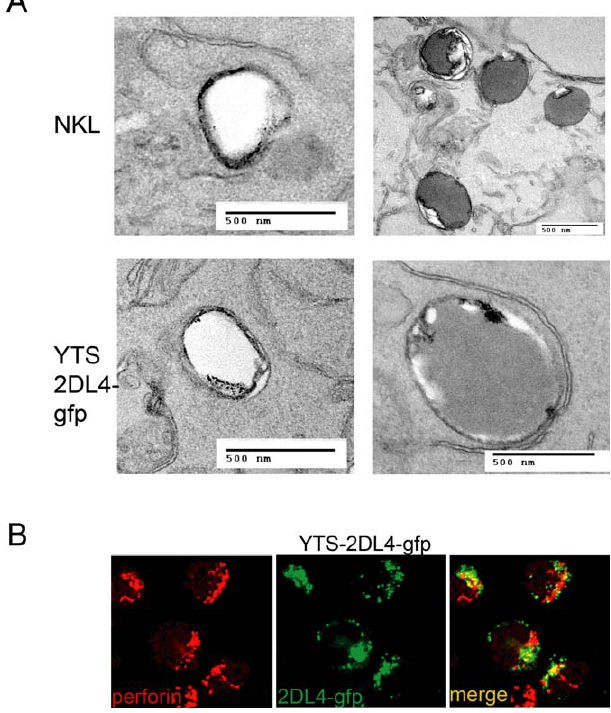
Electron Microscopy (A) The NK cell lines NKL and YTS-2DL4-gfp were loaded with anti- KIR2DL4 mAb 33 for 120 min. Endocytosed receptor was detected using HRP-conjugated sheep anti-F(ab 9 ) 2 mouse IgG. The HRP reaction product visible as a dark stain identifies the location of endocytosed KIR2DL4. Vesicular structures positive for KIR2DL4 ranged between 250 and 500 nm in size. (B) The NK cell line YTS, stably transfected with KIR2DL4-gfp (YTS-2DL4- gfp), was fixed, permeabilized, and stained with antibody to perforin followed by Alexa-568–conjugated secondary antibodies. Single confocal sections are